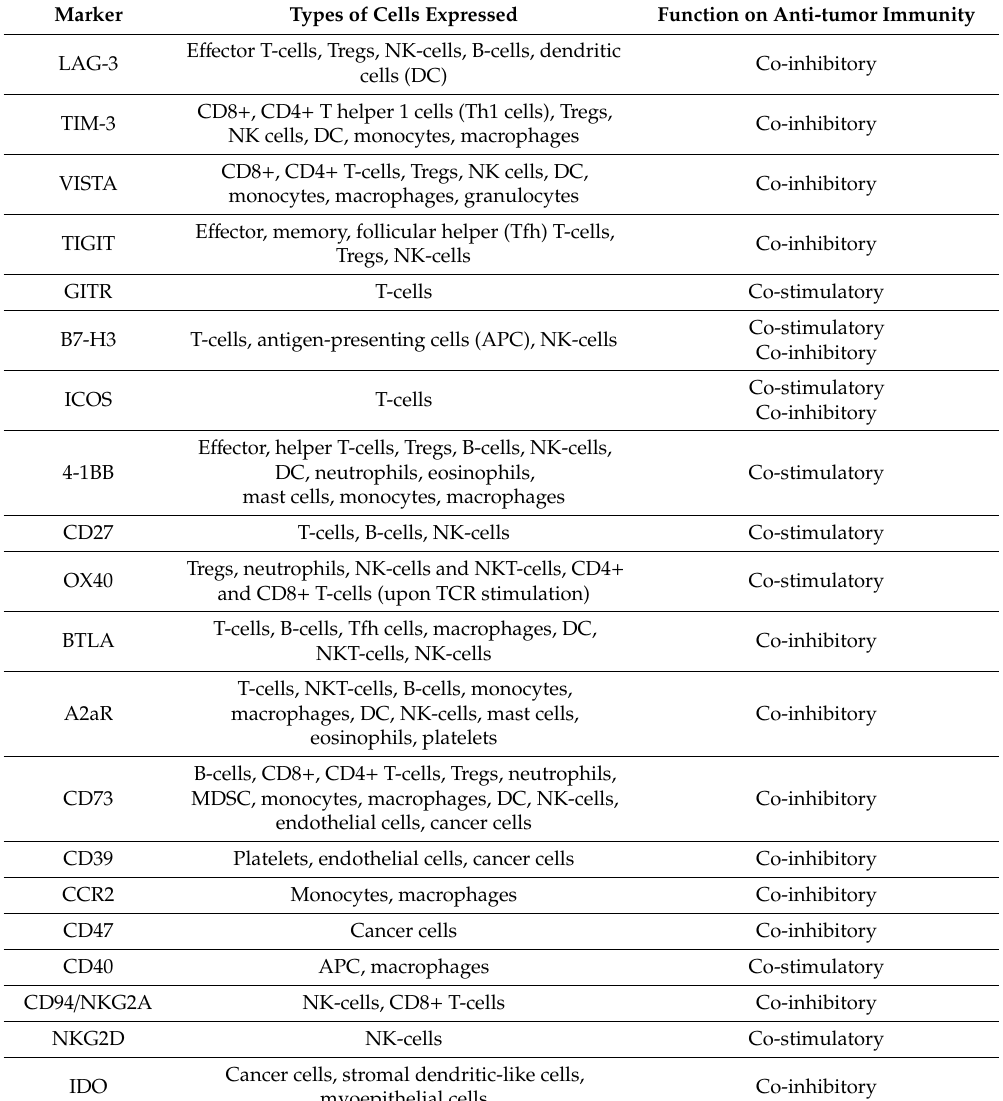
Table 5. Overview of immune-related markers’ characteristics including origin of expression and their role in anti-tumor